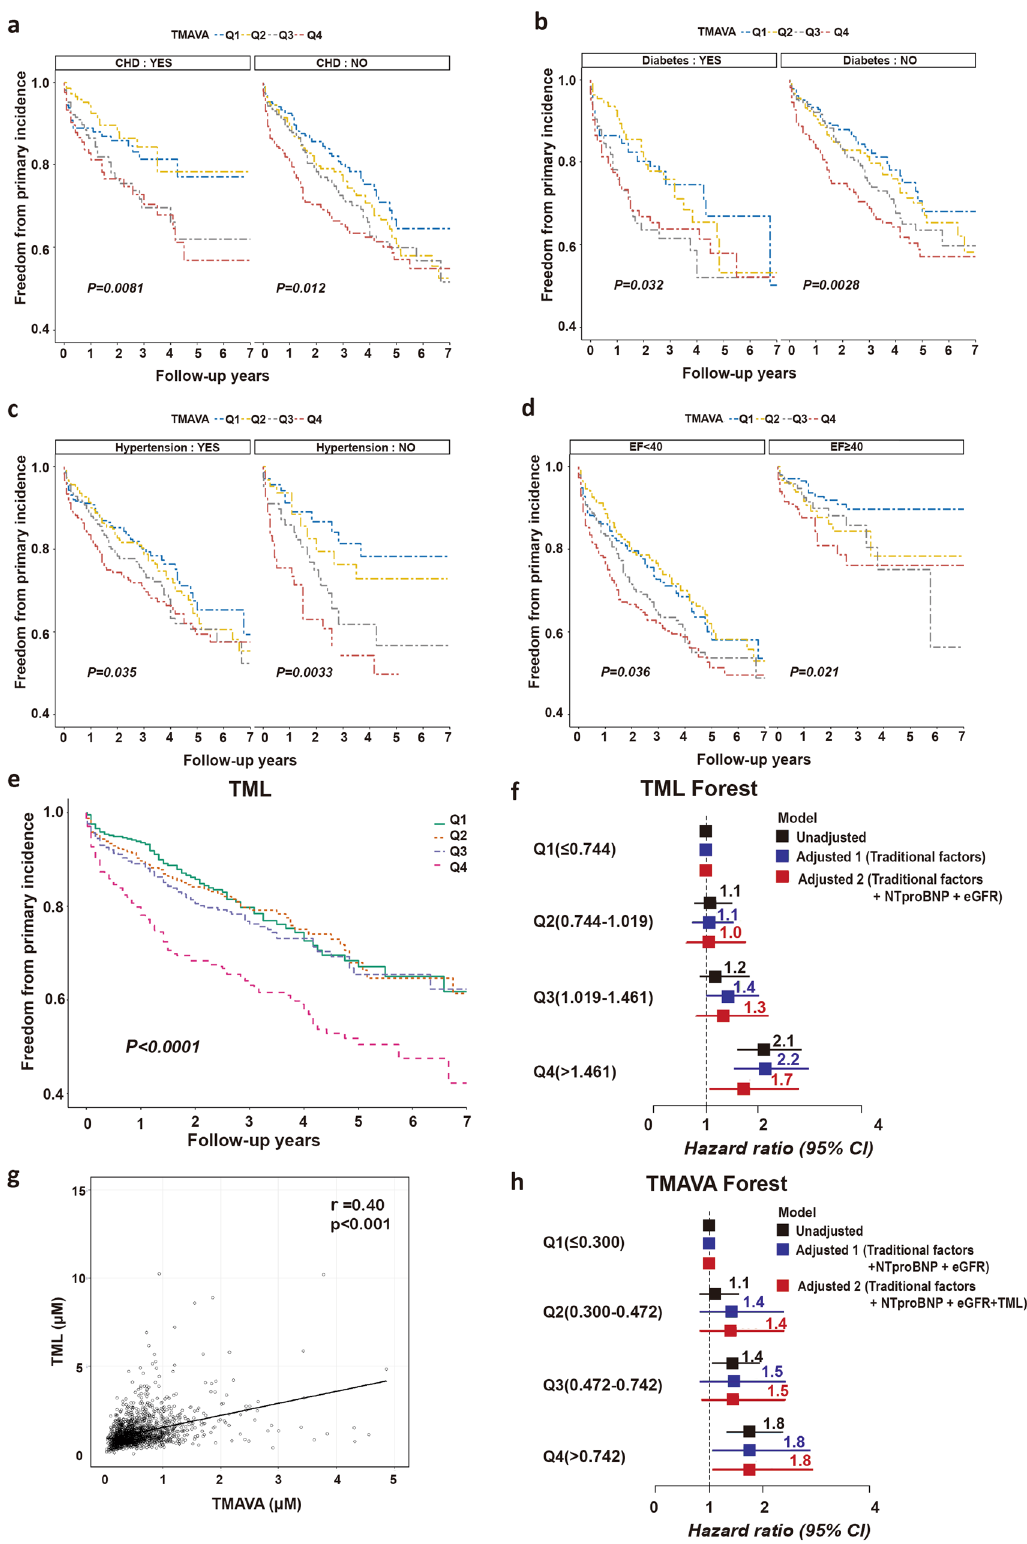
was performed after 12 weeks of TMAVA treatment combined with HFD. TMAVA-treated mice showed signi fi cantly altered lipid pro fi les compared with control, as indicated by principal component analysis (PCA) (Supplementary Fig. 4a). Hierarchical cluster analysis heat map indicated that TG and diglycerides (DG) were elevated (Fig. 3p and Supplementary Fig. 4b). FFA of